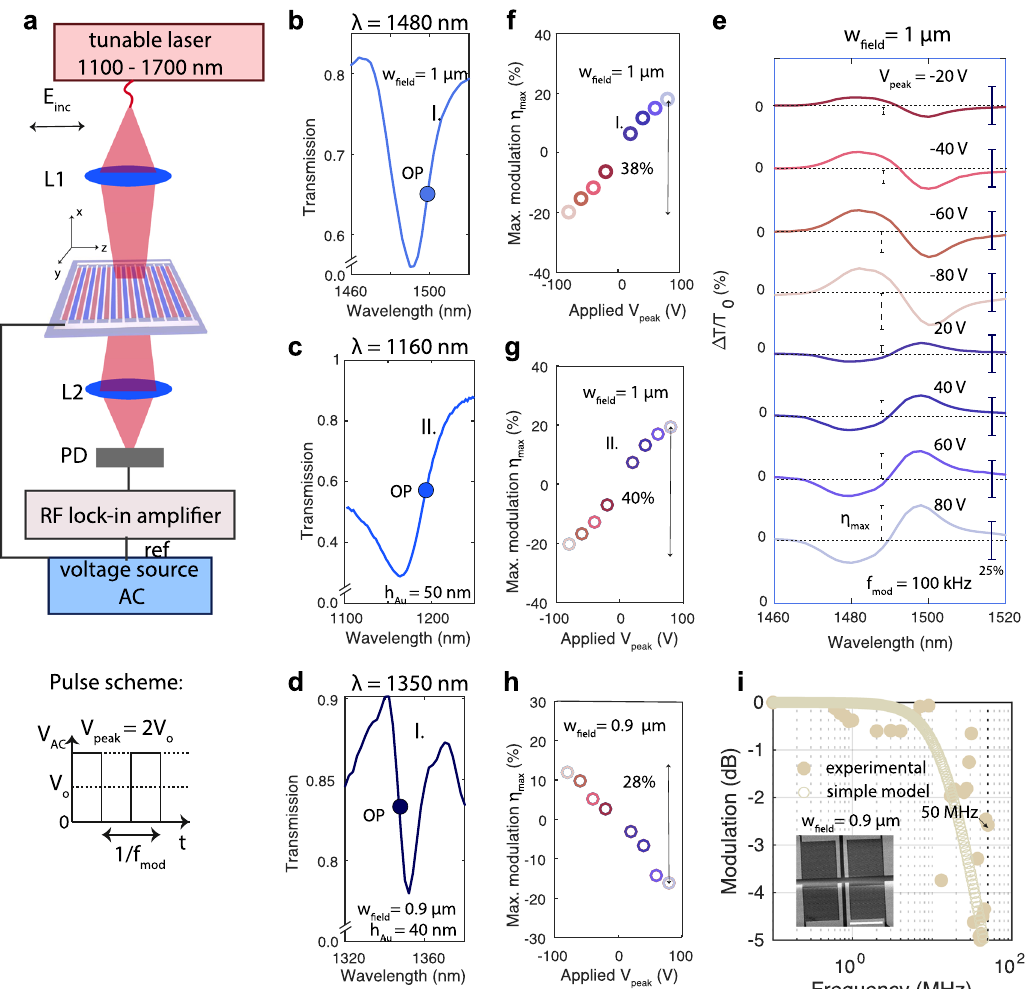
Fig. 4 Radio-frequency tuning properties. a An AC voltage source drives the modulators and the introduced intensity modulation is detected with a lock- in ampli fi er. Inset: The utilized pulse scheme combines a DC offset voltage with an AC voltage. b – d Three different resonances are investigated: mode I. (at 1480 nm) and II. (at 1160 nm) for w fi eld = 1 μ m ( h Au = 50 nm) and mode I. (at 1350 nm) for w fi eld = 0.9 μ m ( h Au = 40 nm). The operation point (OP) is marked by the colored bullet. e Detailed wavelength-resolved modulation depth (solid vertical bar represents η = 25%) for w fi eld = 1 μ m at f mod ¼ 100 kHz reveals a linear dependence of the maximum intensity modulation η (dashed vertical bars) on the applied V peak (shown in f , for mode I. and g for mode max II.)). A similar behavior is reported for a second modulator with w fi eld = 0.9 μ m (shown in h ). In all devices, we achieve a maximal modulation strength up to 30 – 40%. i The modulation strength (normalized to its value at 100 kHz) is reported for one pixel of the 2 × 2 SLM shown in the inset (scale bar = 200 μ m) as a function of f mod , where the full (empty) circles are experimental (analytical) data. A 3 dB decay close to 50 MHz is observed (further details